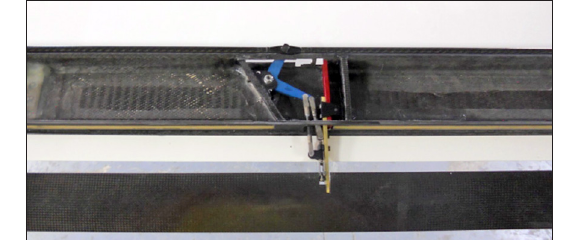
Fig. 9. LAK-17B with the VGMF performing a test flight (Photo: P. Lauk)